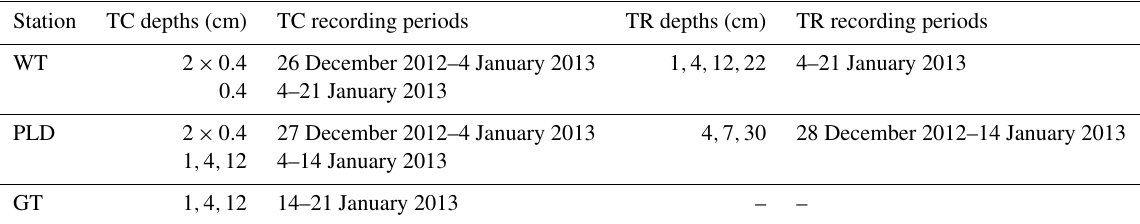
Table C1. Soil thermometer devices, depths of their deployment, and recording periods for the stations WT (water track), PLD (paleolake delta), and GT (glacial